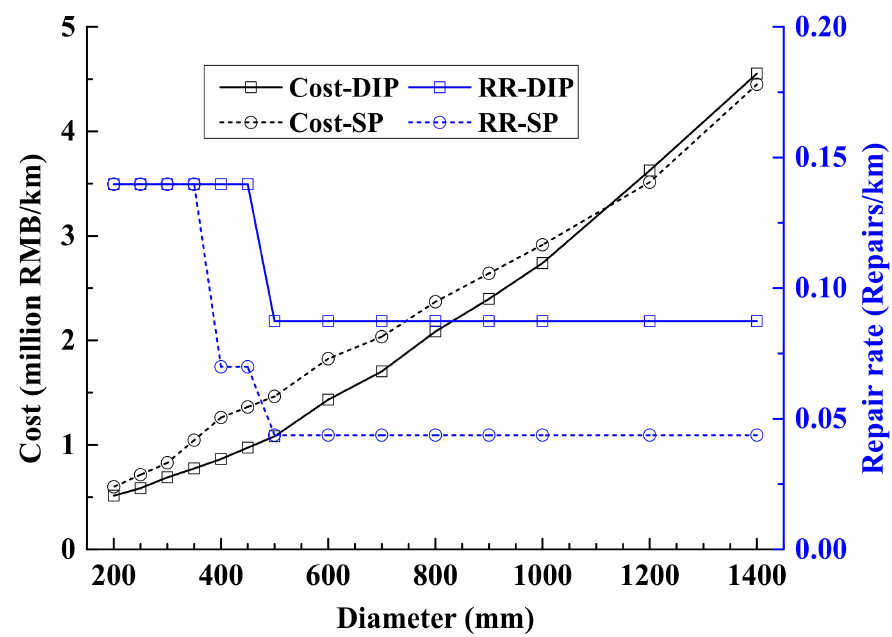
Figure 9. Construction cost and seismic repair rate of the pipelines in Z